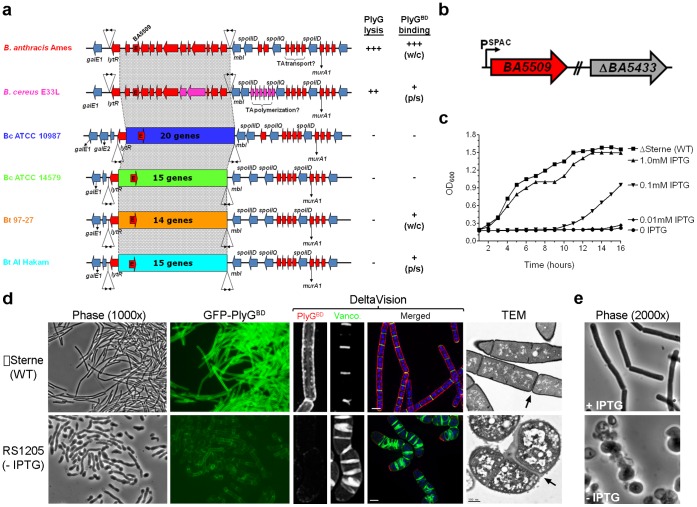
Identification and analysis of 2-epimerase in B. anthracis.(A) sps loci of the B. cereus lineage. Islands of variable sps genes are connected by gray regions and denoted by different colors. Conserved flanking sequences are shown. Red shaded loci (not in Ames) are cell wall-biosynthetic genes similar to that encoded by Ames. Inverted arrows are repeat elements. Susceptibility to PlyG lysis and GFP-PlyGBD surface binding are shown. For PlyG lysis, the “+++” designation is based on an assay [8] for zones of complete bacteriolysis on agar plates overlaid with the indicated organism and treated with a 10 µl drop of PBS containing 1 µg of PlyG; “++” indicates a slight reduction in activity compared to complete bacteriolysis, and “-“ indicates an absence of bacteriolysis. For PlyGBD binding, designations are based on exposure times needed to clearly visualize binding of GFP-PlyGBD to target organisms by fluorescence microscopy; “+++” indicates a <5 second exposure, “+” indicates a 15–30 second exposure, and “-“ indicates no fluorescence is observed. Abbreviations: w/c, whole-cell binding; p/s, polar/septal binding. (B) Genetic representation of 2-epimerase double mutant, RS1205. (C) Growth of RS1205 (with indicated IPTG concentrations) compared to the parental wild-type strain ΔSterne. Mean averages are shown (n = 3) with standard deviations. (D) Morphological analysis of RS1205 after five hours of growth without IPTG. Phase contrast images and corresponding fluorescence fields are shown for GFP-PlyGBD-labeled RS1205 (5 second exposure) and B. anthracis ΔSterne (30 second exposure). For Deltavision images, NPS (red) was labeled with rhodamine-PlyGBD, division septa (green) were labeled with vancomycin BODIPY FL, and DNA (blue) was labeled with DAPI. TEM images are shown with scale bars (500 nm) and arrows denote some division septa. (E) Phase contrast microscopic images of RS1205 grown for 12 hours with and without IPTG (5 µM).